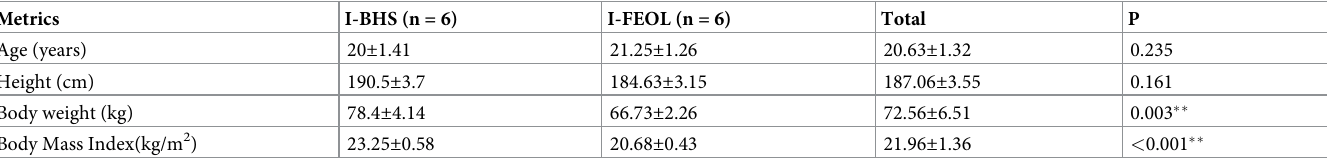
Table 1. Basic information of the participates.